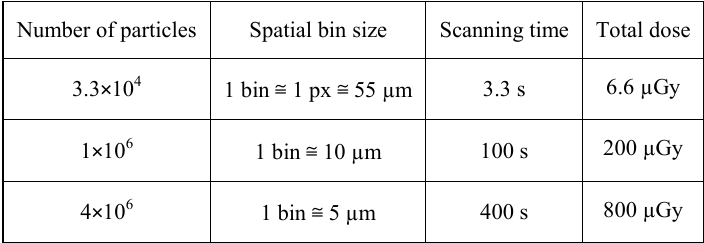
Table 2. Lowest event count statistics depending on the spatial resolution. Values given for a